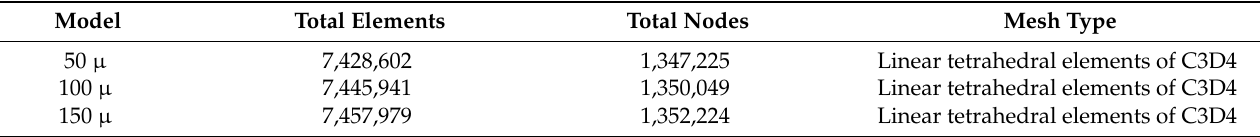
Table 2. Study groups. Table 3. Nodes and elements for the different tested